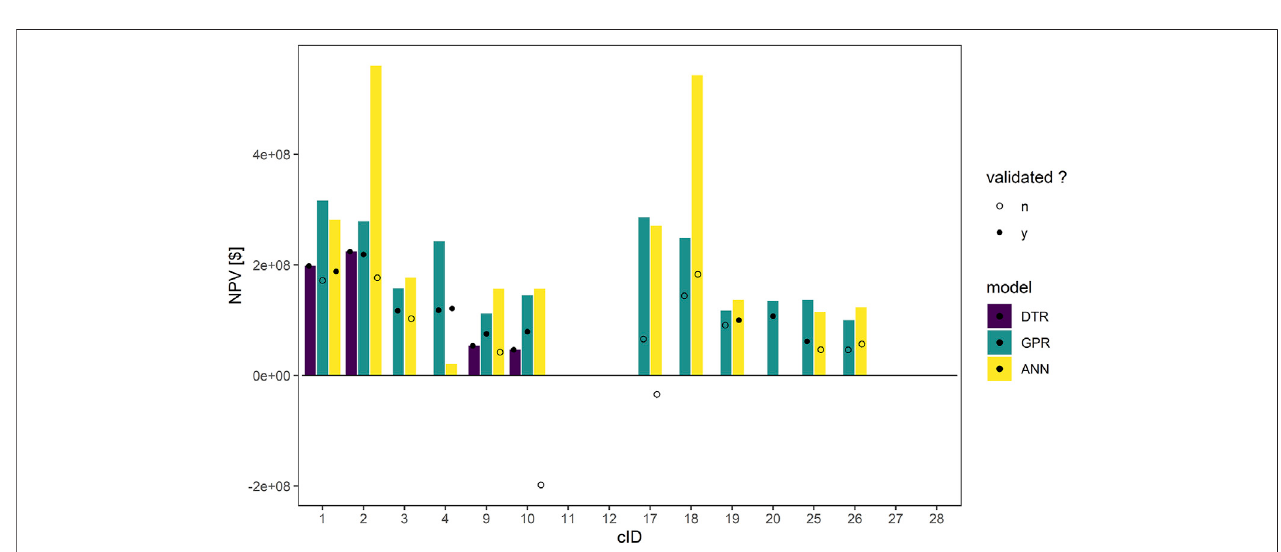
FIGURE 6 | Results of the SSO for all three surrogate model types and the corresponding validation simulation.